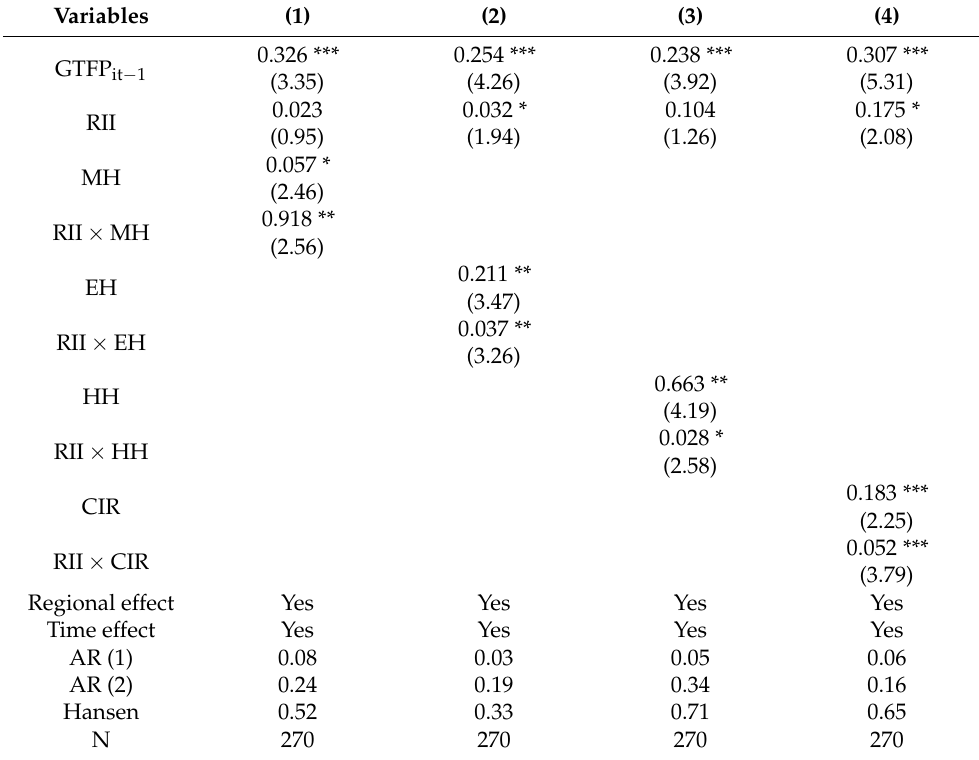
Table 8. The interactive effect of rural human capital or land transfer and integration of rural three